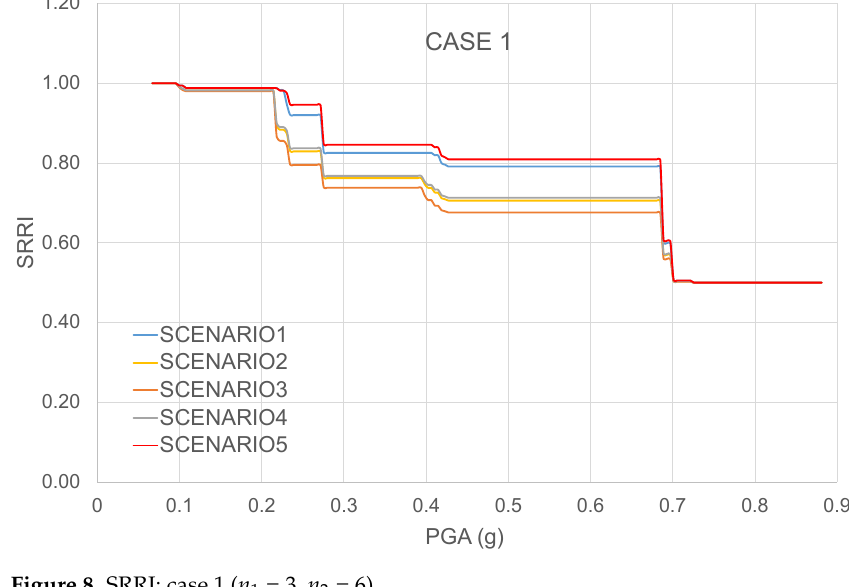
Figure 8. SRRI: case 1 ( n 1 = 3, n 2 = 6).